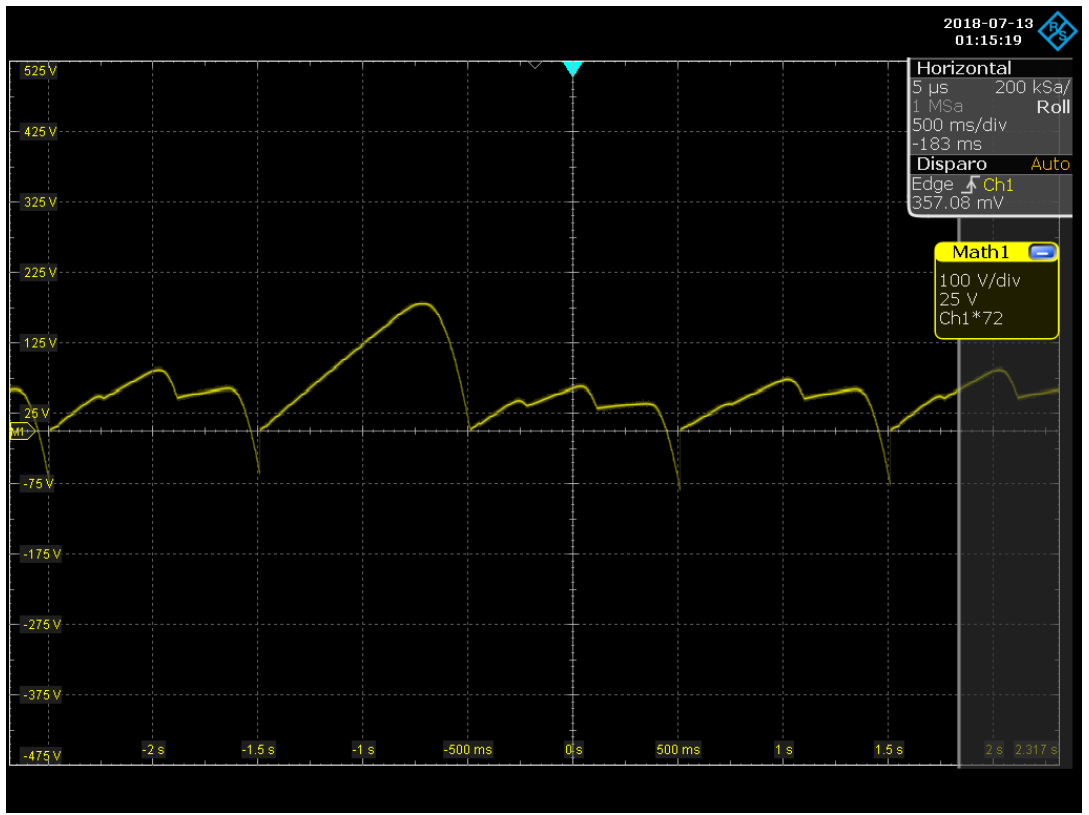
Figure 16. Testing of the model of three PVs panels series emulated with different G